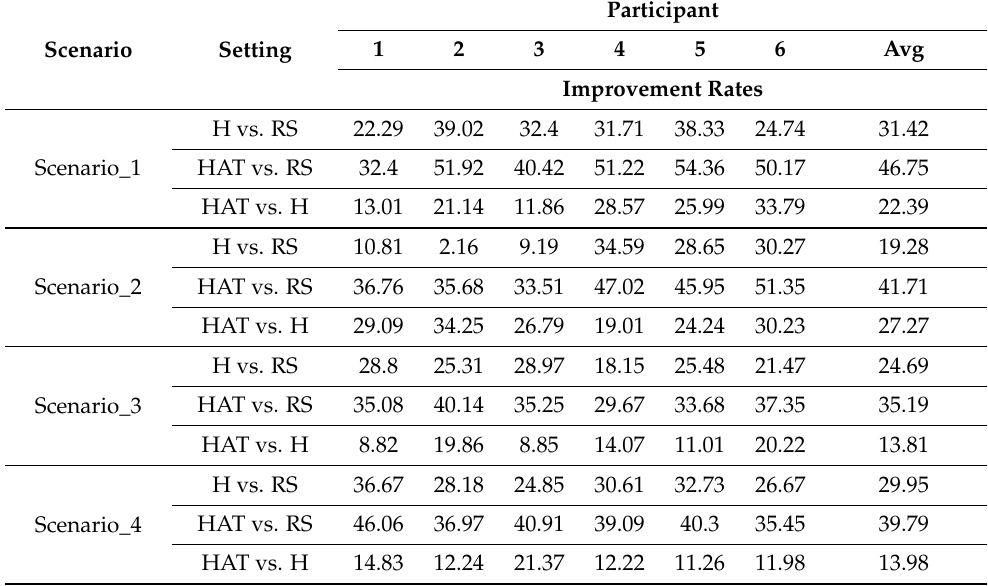
Table 4. A Comparison of improvement rate in Scenarios_1–4. HAT represents experiments with con- trol switching between the human and robot, H represents experiments with only human instructions, and RS represents experiments with only robot random